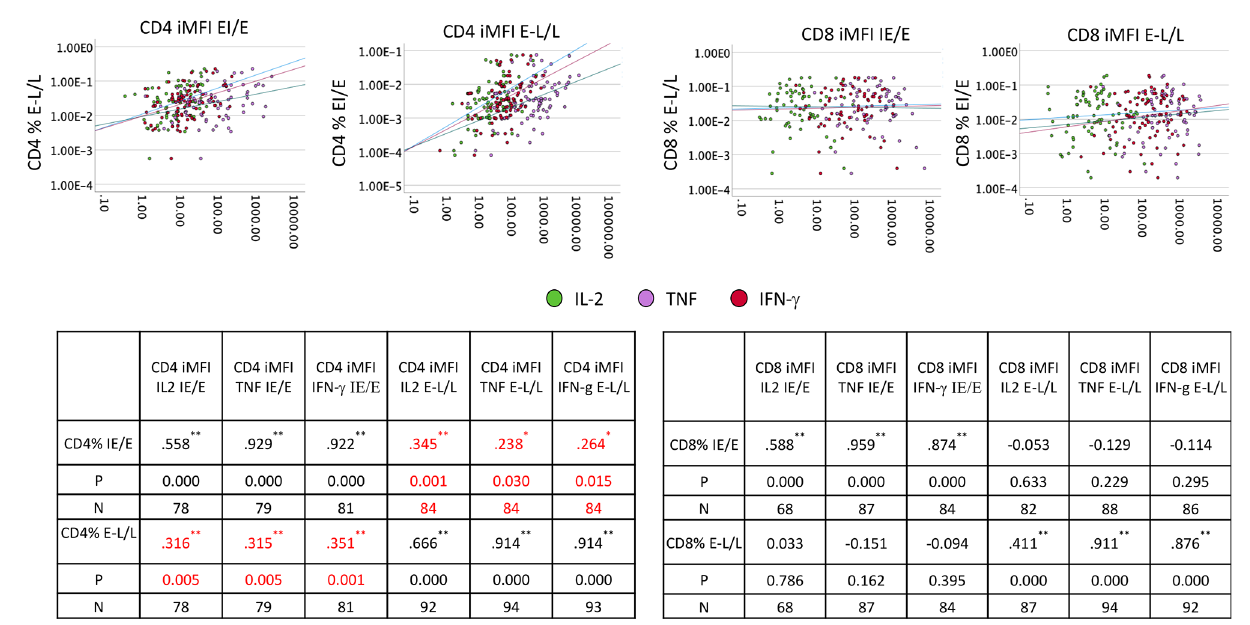
FIGURE 6 | IE/E and E-L/L CD4 and CD8 T-cell response correlation. PBMCs from males (n=47) and females (n=47) were stimulated and processed for intracellular cytokine staining. Thereafter, the iMFI for each cytokine was calculated. Scatter plots show the association of IE/E protein speci fi c with E-L/L protein-speci fi c CD4 and CD8 T-cell responses. The inset tables show the Pearson R correlation coef fi cient for each association comparison with the level of signi fi cance. * p ≤ 0.05; ** p ≤